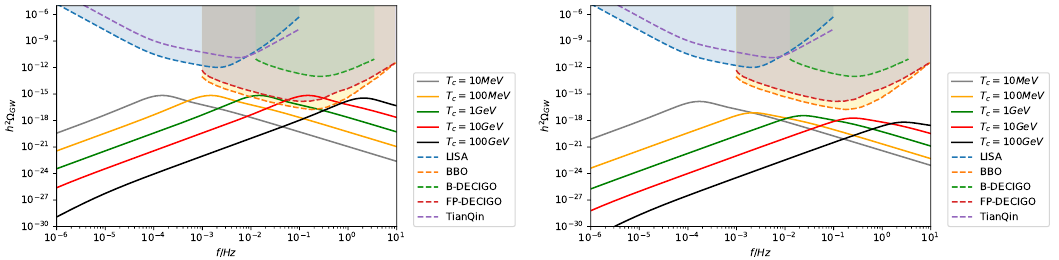
Figure 5 . GW spectra with the same condition as in figure 4, but with varying T c in several orders. The right panel includes the SM contribution by ζ = 1 , while the left panel doe not ( ζ = 0